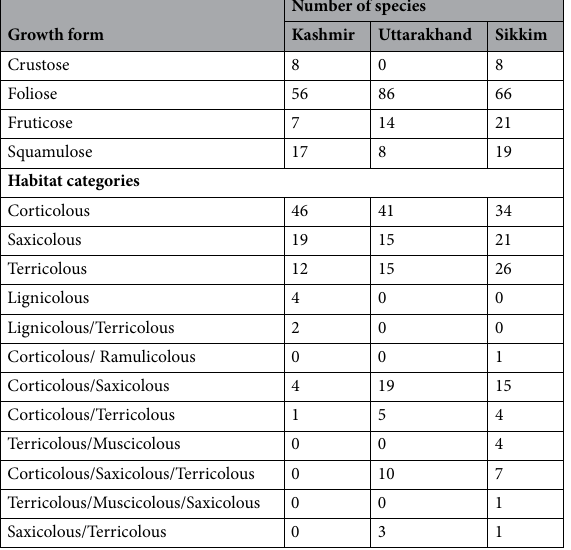
Table 2. Number of macrolichen species belonging to various growth forms and habitat categories in Kashmir, Uttarakhand and Sikkim.